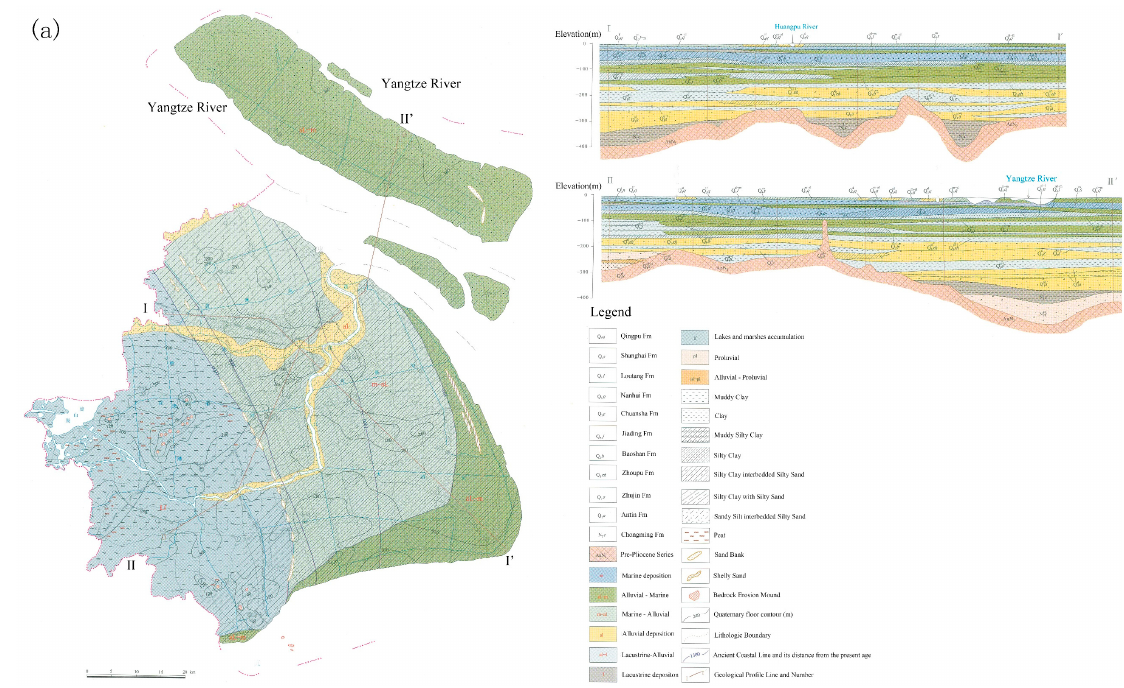
Figure 3. Cont. Figure 3.